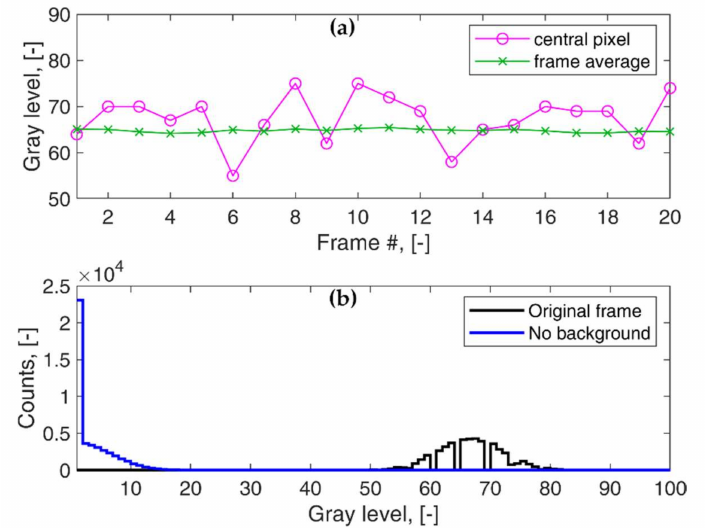
Figure 6. ( a ) Gray level, evaluated over time, during the average background computation. The pink curve refers to a single pixel, e.g., that in the center of the frame. The green curve is the average gray value over the entire 256 × 256 pixel frame. ( b ) Histogram of gray levels for a raw frame (black) and the corresponding histogram after background removal